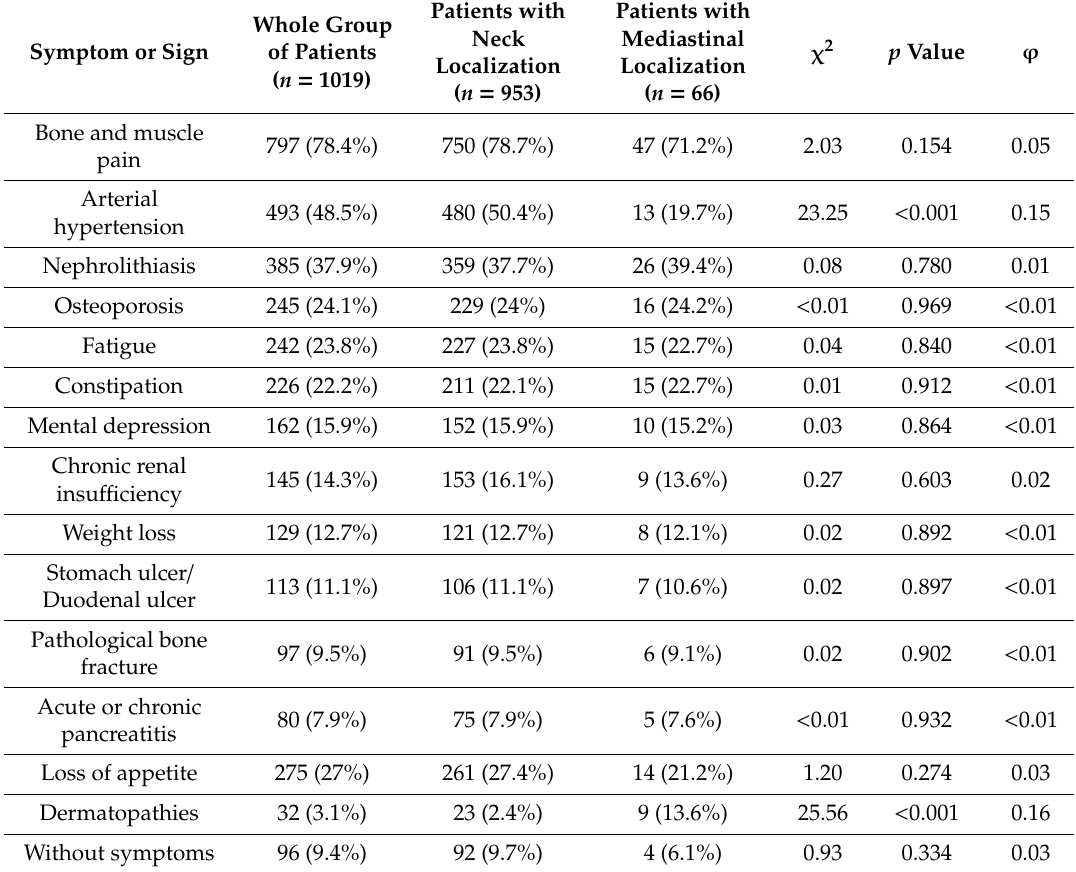
Table 1. Symptoms of 1019 patients operated on for Primary hyperparathyroidism